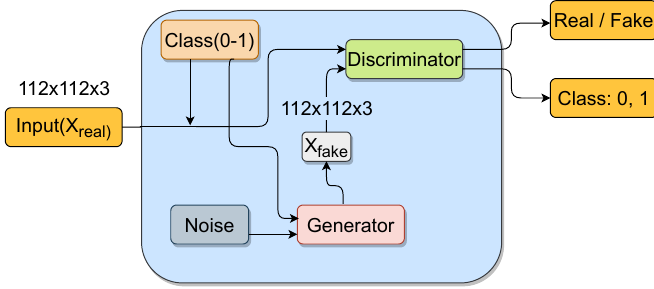
Figure 2. Schematic diagram of